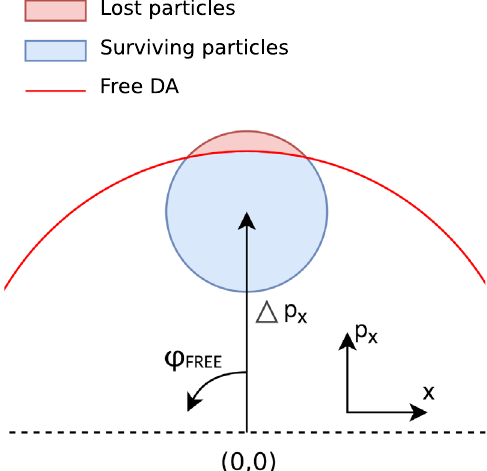
lost.FIG. 8. Diagram showing where the losses in the particle bunch occur as a result of reaching the free dynamic aperture. As the kick amplitude ( Δ p x ) increases more particles will cross the free dynamic aperture and will be lost.